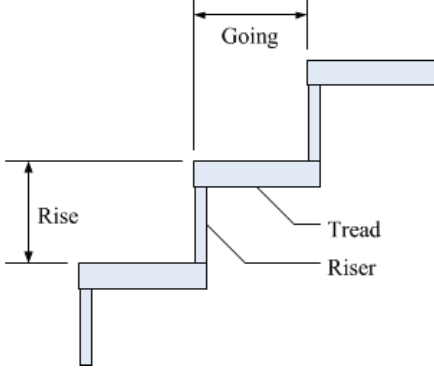
Figure 23. The structure of the